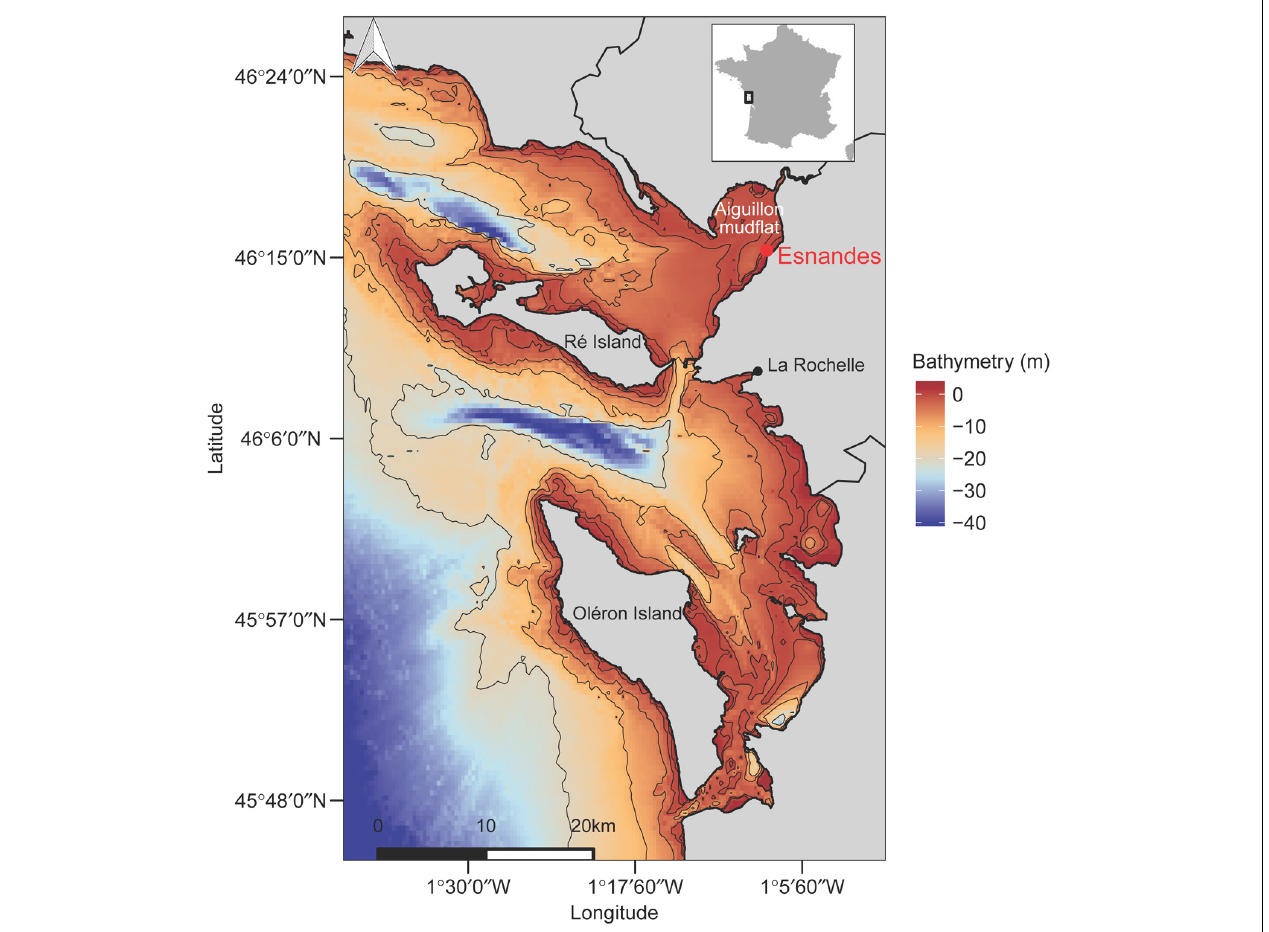
FIGURE 1 | A map of the Pertuis Charentais, France, showing the Bay of l’Aiguillon and the location of our sampling site, Esnandes (red dot). Bathymetry was retrieved from the General Bathymetric Chart of the Oceans (GEBCO International) database and plotted using R software with the use of the marmap package (Pante and Simon-Bouhet,